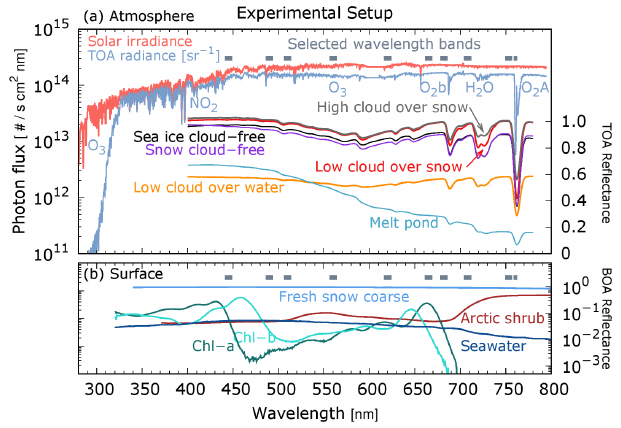
Figure 1. Plots of the solar irradiance, the radiance of a cloud (Earthshine), and reflectances at the top (TOA) and bottom (BOA) of the atmosphere as a function of wavelength from 280 to 800nm. The cloud radiance was observed by GOME on 15 May 2001, over the Kara Sea (80.53 ◦ N, 75.99 ◦ E). Modeled R TOA (nadir, so- λ lar zenith 40 ◦ ) displays a water cloud, placed at 3km and opti- cally dense 30, above seawater and snow, with cloud-free sea ice, snow, and melt pond spectrum. The lower panel shows the black- sky hemispherical reflectance at the ground of relevant Arctic sur- face components. Chlorophyll absorption is taken from Clementson and Wojtasiewicz (2019) and plotted for a May 2016 concentration of 12mgm − 3 observed in the Bering Sea (Frey et al., 2018). Arc- tic shrub and coarse snow data are taken from the ECOSTRESS and ASTER spectral libraries (Meerdink et al., 2019; Baldridge et al., 2009). Melt pond and sea ice albedos are from Istomina et al.